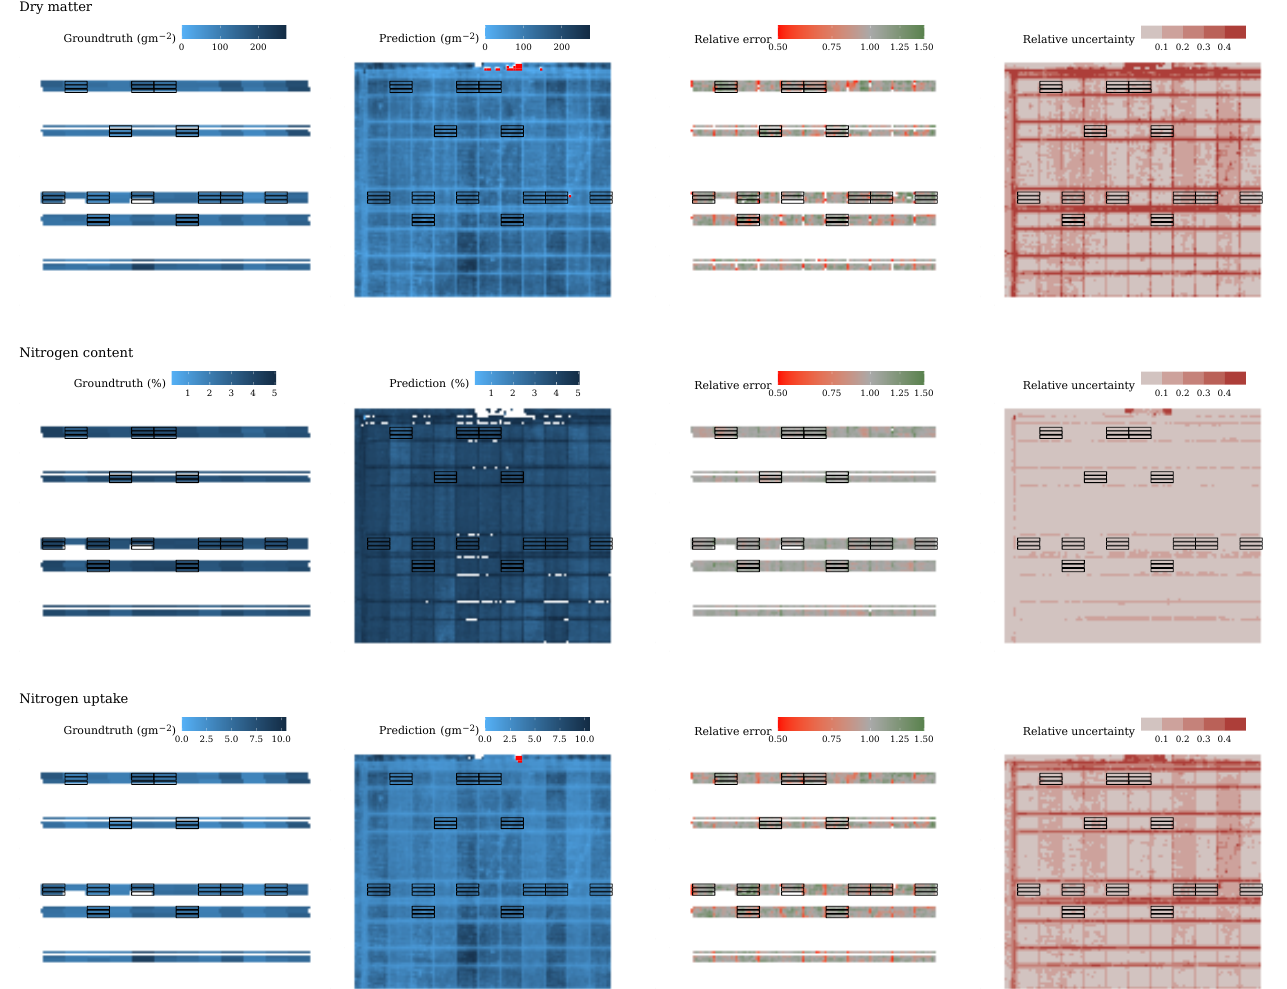
Figure 5. Ground truth (first column), prediction (second column), relative prediction error (third column), and relative prediction uncertainty (fourth column) maps for individual crop properties. A relative error of 1 corresponds to no prediction error. The value estimates were generated using the highest-performing models. These were Gaussian process regression models with the squared expo- nential kernel trained to raw push-broom hyperspectral reflectance data augmented with apparent soil electrical conductivity measurements. The predicted crop property is indicated above each row. Values are not available for the easternmost experimental plot column, which was not covered by the push-broom imagery. The color scale upper cutoffs for the predictions are 120% of the highest ground truth values, and negative predictions are not shown. The displayed errors are trimmed at ± 50%, and the uncertainty values at 50%. The biomass collection strips corresponding to the testing data partition are marked with black